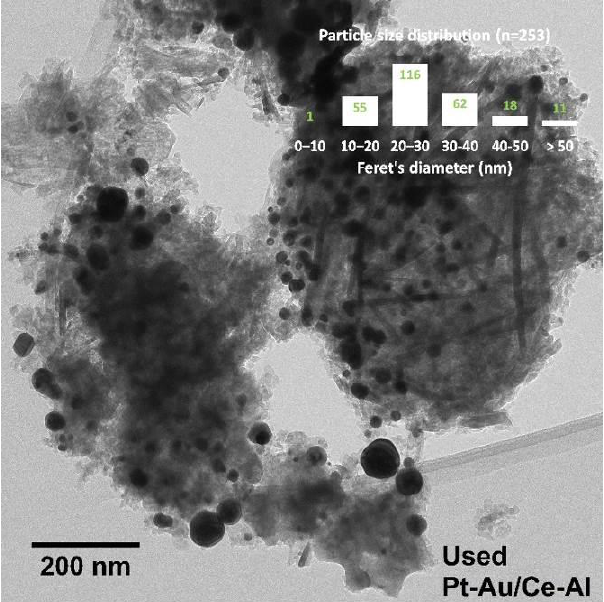
Figure 14. HR-TEM image of the used Pt–Au / Ce–Al catalyst after the stability test and in situ regeneration.